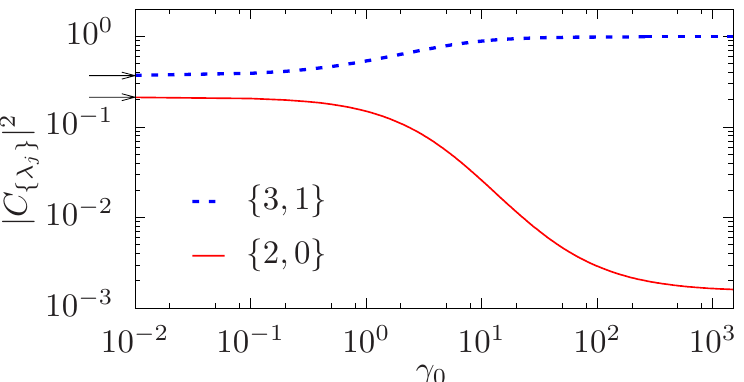
| 2 of the super-Tonks state { n Figure 6: Populations | C { λ } j } = { 2,0 } (see text) for quenches from the interacting ground state at body bound state { n j γ > 0 to γ = − 40 for N = 4 particles. The black arrows indicate the populations for the 0 quench from the ideal-gas ground